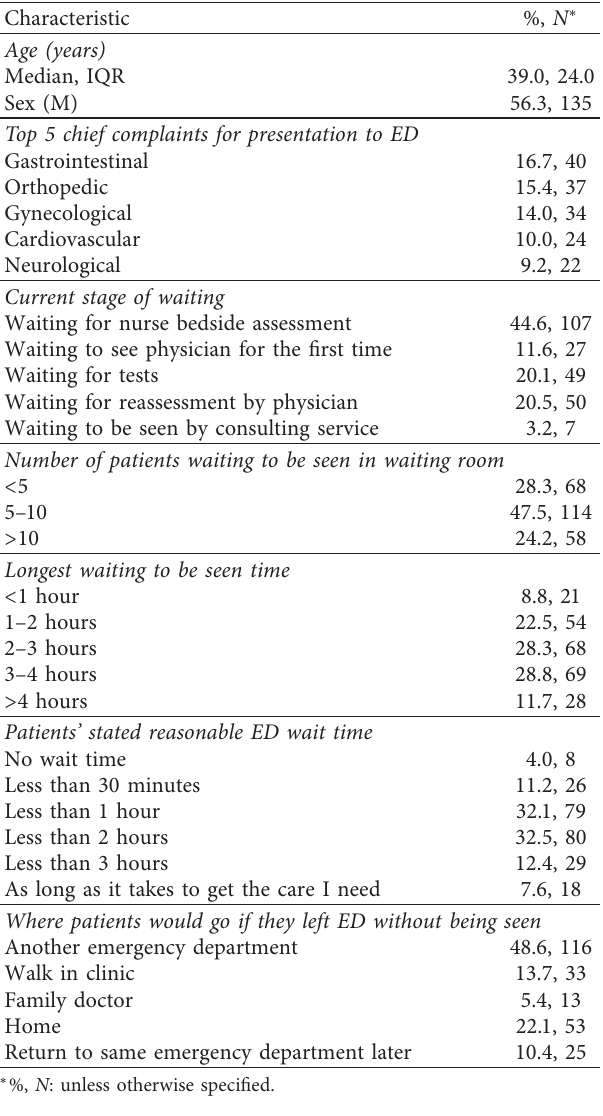
Table 1: Demographics and baseline characteristics of emergency department waiting room survey respondents ( N �